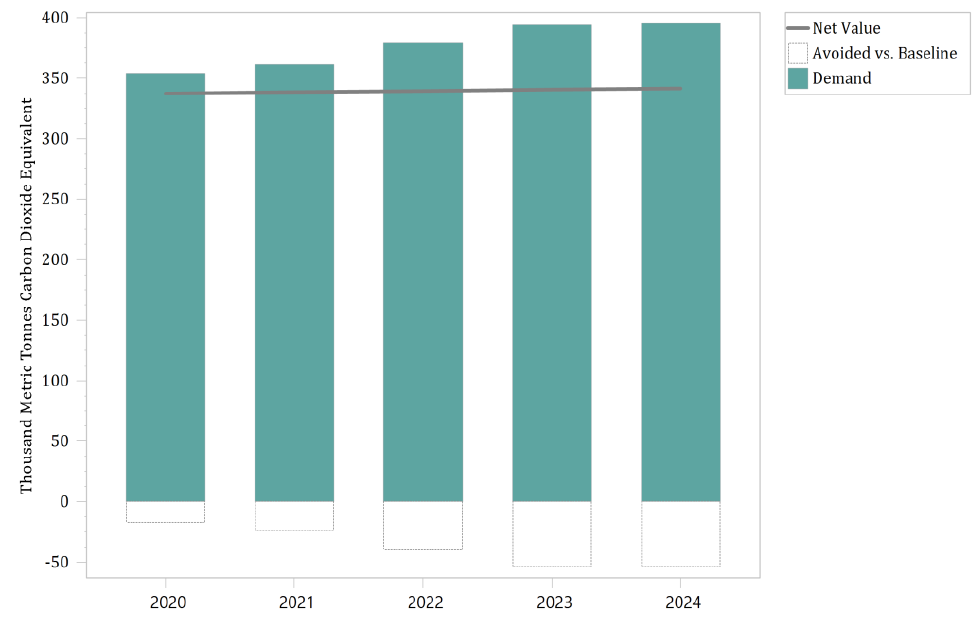
Figure 5. Carbon emissions from urban electricity generation under simulation versus base year.